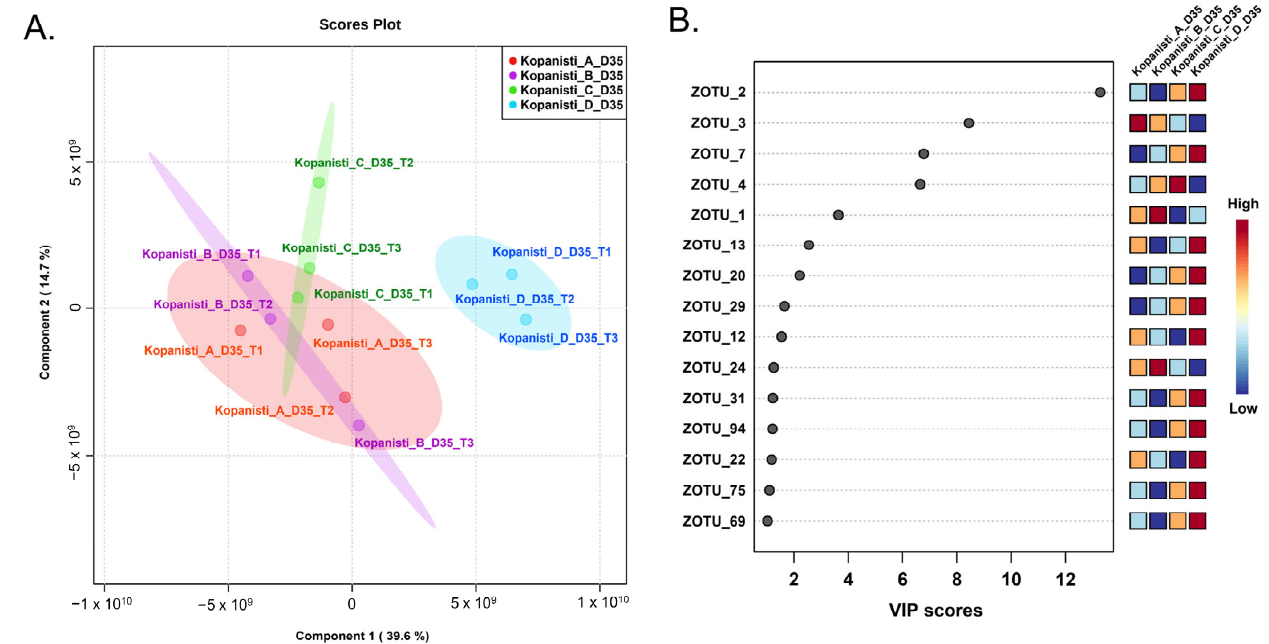
Figure 4. Partial least squares discriminant analysis (PLS-DA) of the bacteria zOTUs detected in the Kopanisti A, B, C and D samples on Day 35. Samples are coloured according to the Kopanisti type, i.e., red for Kopanisti A, purple for Kopanisti B, green for Kopanisti C and blue for Kopanisti D ( A ). Most influential bacteria zOTUs of the Kopanisti A, B, C and D samples on Day 35 were based on the Variable Importance in Projection (VIP) scores from the PLS-DA. The colour bar indicates the intensity of the variable in the respective Kopanisti type ( B ).